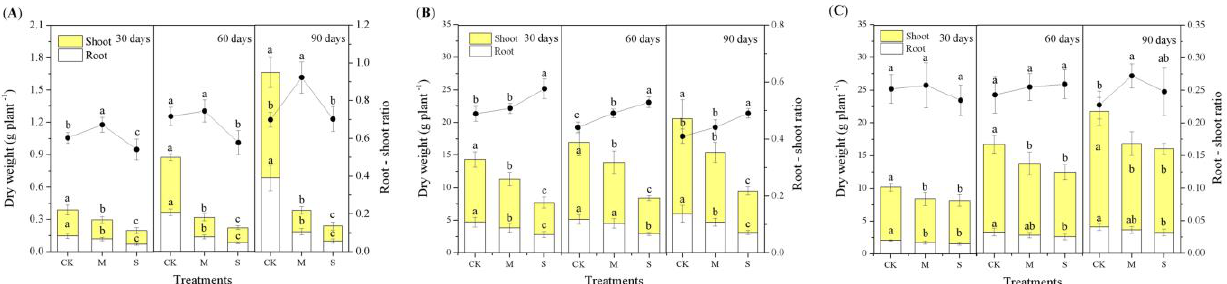
Figure 2. Effects of different drought treatments on dry weights (column charts) and root–shoot ratios (line charts) of the three species during three sampling periods. The different lowercase letters denote significant differences among treatments ( p < 0.05). ( A ): moso bamboo, ( B ): Chinese fir, ( C ): masson pine. CK: the control, M: moderate drought, S: severe drought.